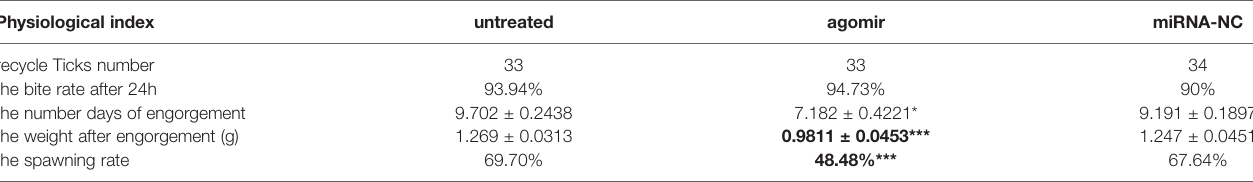
TABLE 3 | Physiological index of ticks in the nov-mir-17 overexpression experiment.